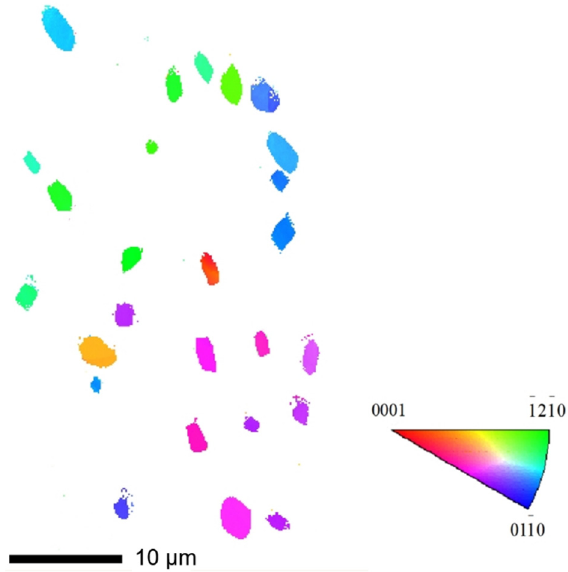
Figure 7. IPF map of α 2 particles in the Area of Interest (AOI).